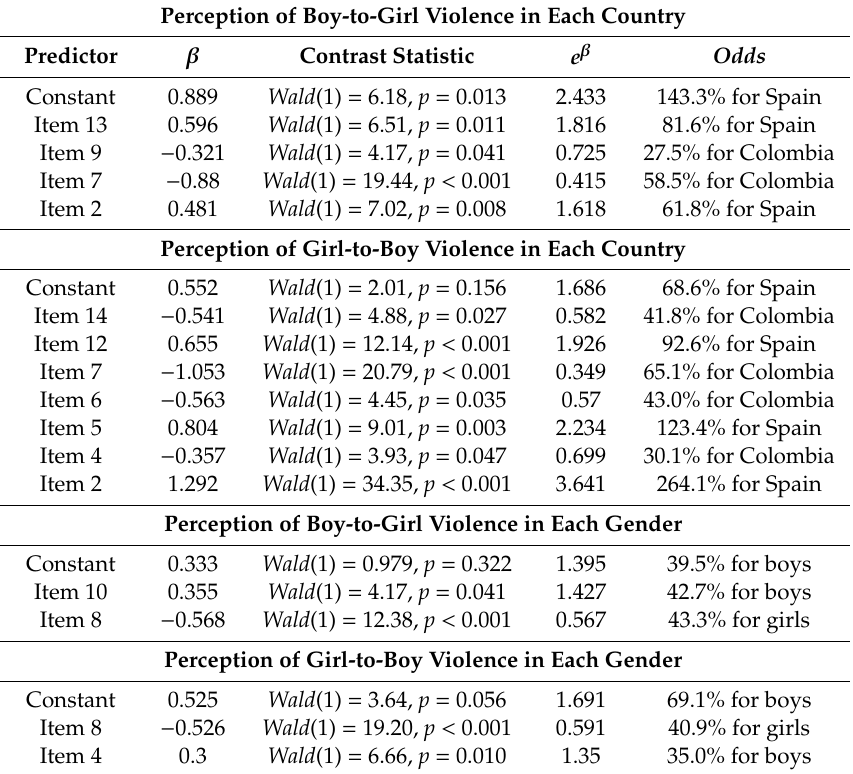
Table 7. Regression coe ffi cients of the di ff erent logistic regression